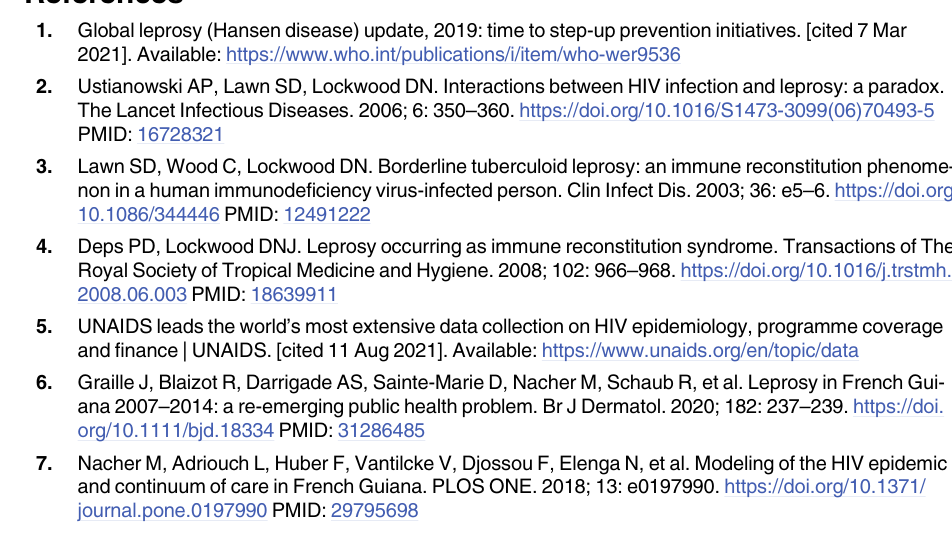
S1 Table. Epidemiological, clinical and biological characteristics of the 73 patients diag- nosed with leprosy as IRIS included in the systematic review. Legend: F: female; M: male; MtF: male-to-female; SL: skin lesion(s); T1R: type 1 reaction state; T2R: type 2 reaction state; U: ulceration; NT: neuritis; NFI: nerve fonction impairment; Se: sensitive; Mo: motor; 1 :